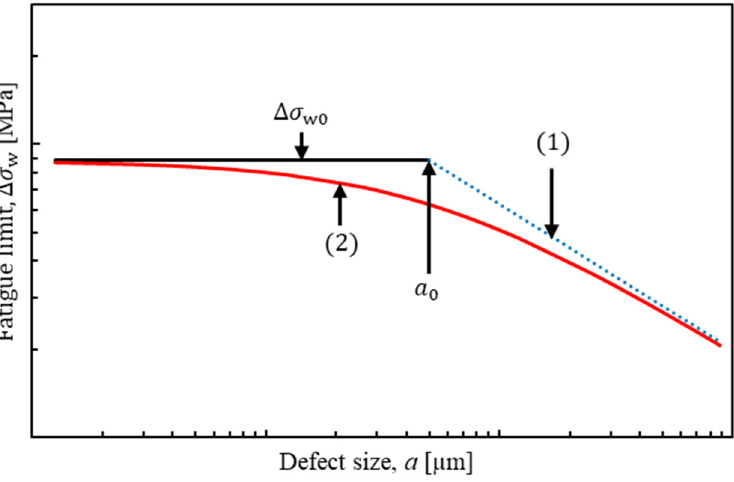
Figure 1. Relationship between the fatigue limit and the defect size.